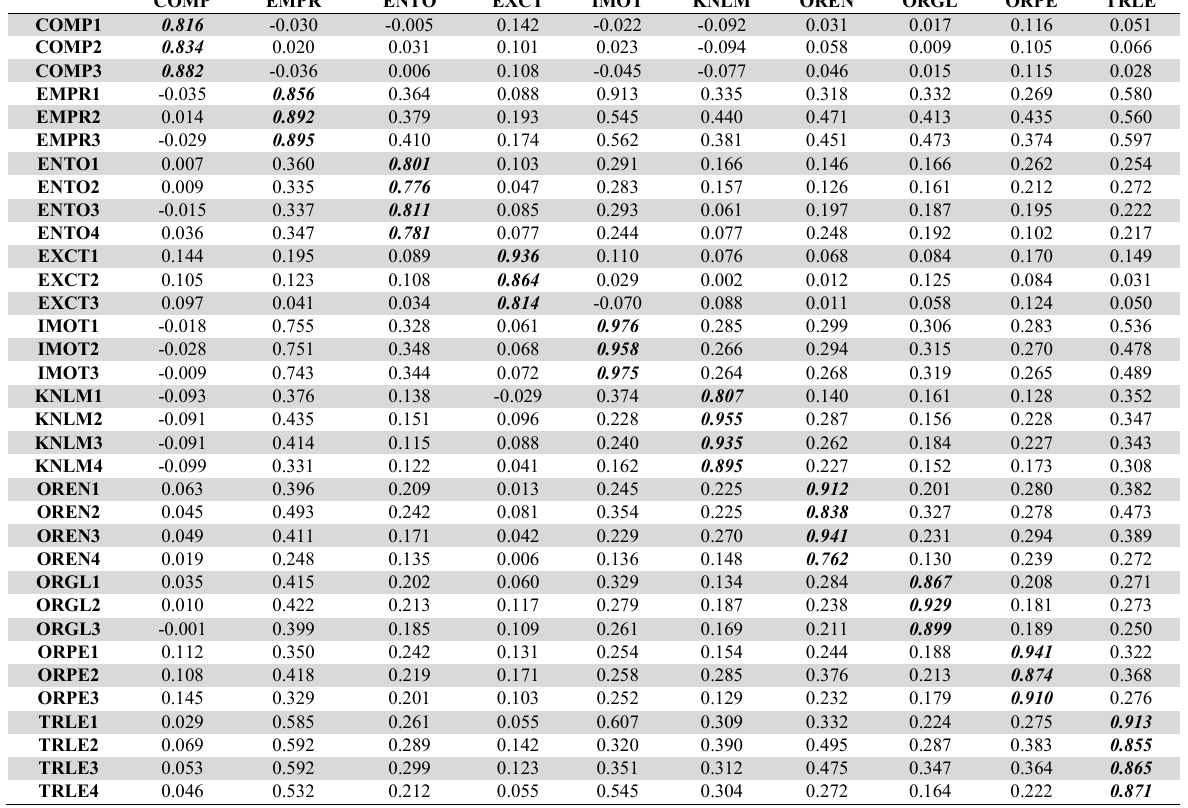
Cross loadings for discriminant validity